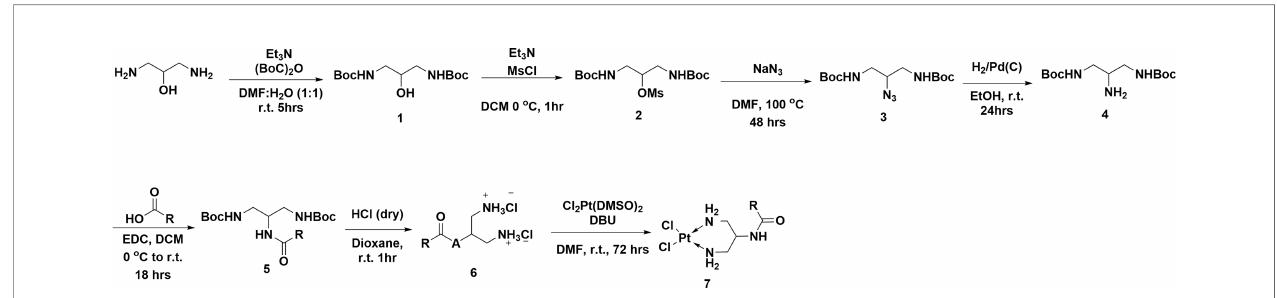
FIGURE 6 | Synthesis of clickable platinum